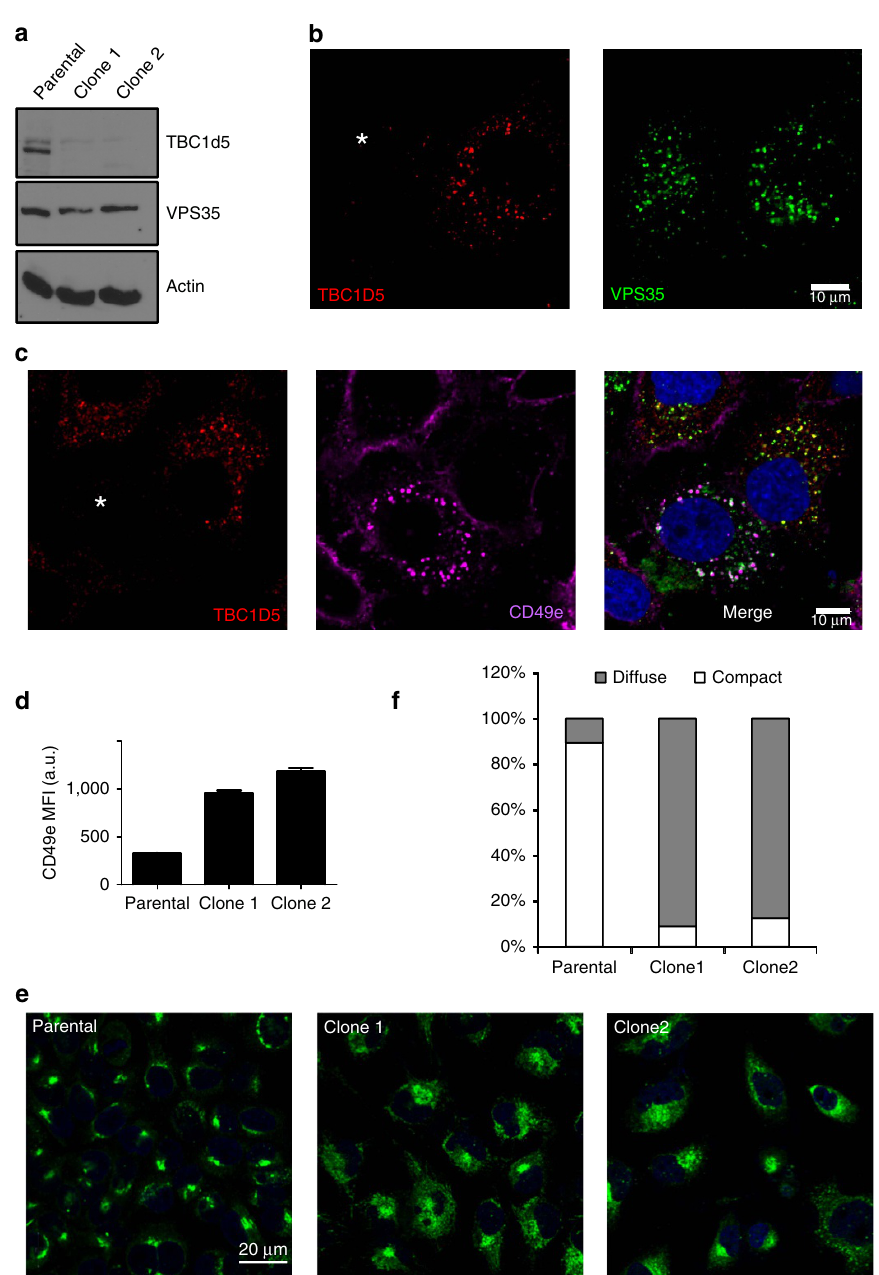
Figure 5 | TBC1d5 is required for retromer-mediated trafficking but not endosomal recruitment of VPS35. ( a ) Levels of TBC1d5, VPS35 and actin expression in TBC1d5 KO (clone 1 and 2) HeLa cell line and parental cells determined by immunoblotting. ( b ) Parental and clone 1 HeLa cells were mixed with 1:1, fixed and stained for TBC1d5 (red) and VPS35 (green). Asterisk represents cell that is devoid of TBC1d5. Scale bar, 10 m m. ( c ) Parental and clone 1 HeLa cells were mixed with 1:1 and incubated with anti-CD49e antibody. The cells were then fixed and stained for TBC1d5 (red), VPS35 (green) and CD49e (magenta). Asterisk represents cell that is devoid of TBC1d5. Scale bar, 10 m m. ( d ) The average mean fluorescence intensity (MFI) of retromer-localized CD49e in parental, clone 1 or clone 2 HeLa cells, with error bar representing s.e.m. Cells were fed anti-CD49e antibody for 1h, then fixed and stained for internalized CD49e and VPS35. MFI was measured using Zen2009 software. One hundred cells from each group were used for comparison. ( e ) TBC1d5 is important for CI-MPR dispersal. Parental, clone 1 or clone 2 Hela cells were fixed and stained with anti-CI-MPR. Scale bar, 20 m m. ( f ) Quantification of e . One hundred cells from each group were scored for either compact or dispersed CI-MPR